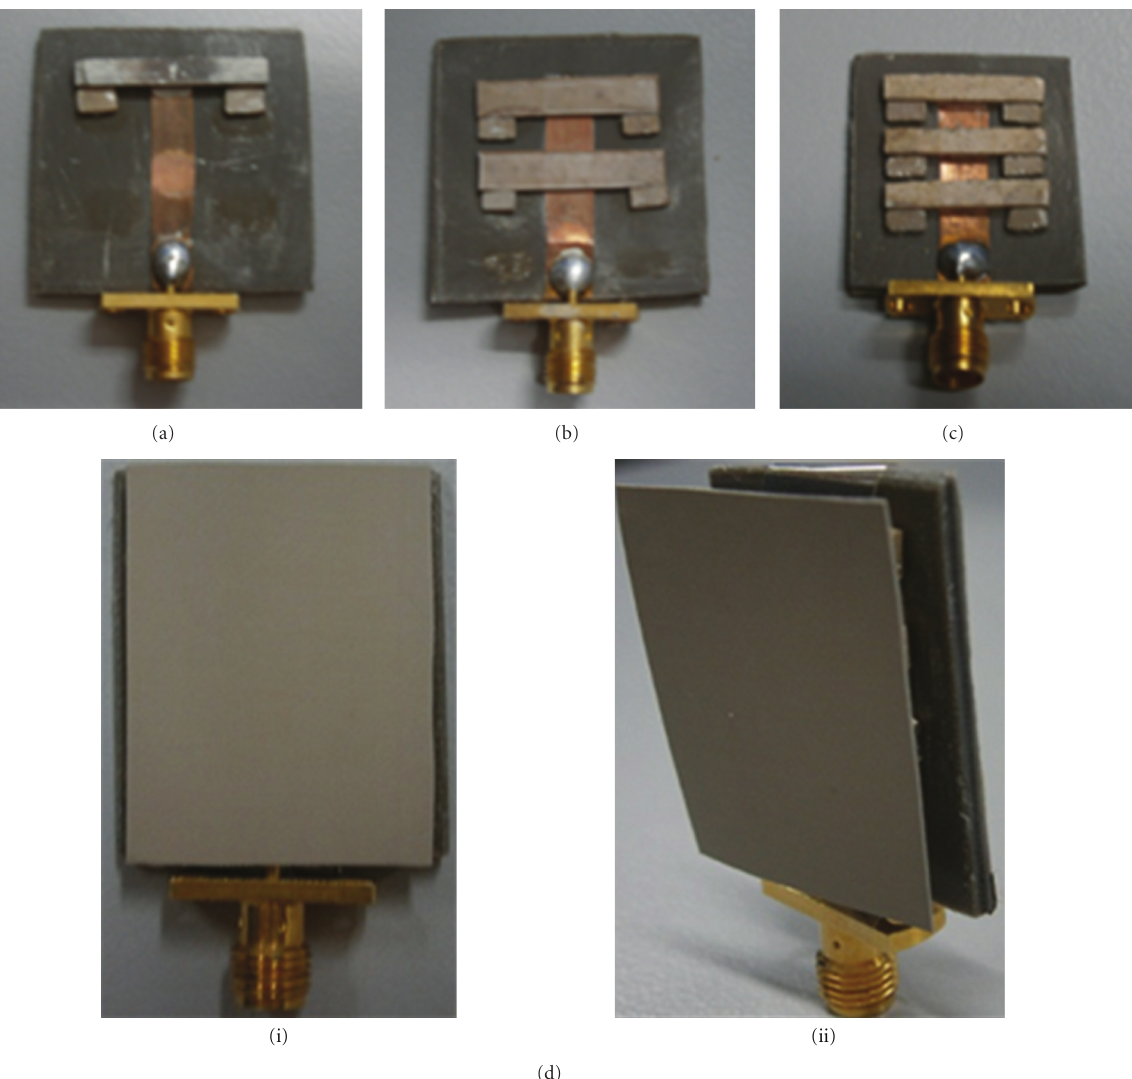
Figure 6: Photograph of fabricated BiT array antennas (a) two BiT ceramic elements (b) four BiT ceramic elements (c) six BiT ceramic elements (d) dielectric layer (i) front view (ii) perspective